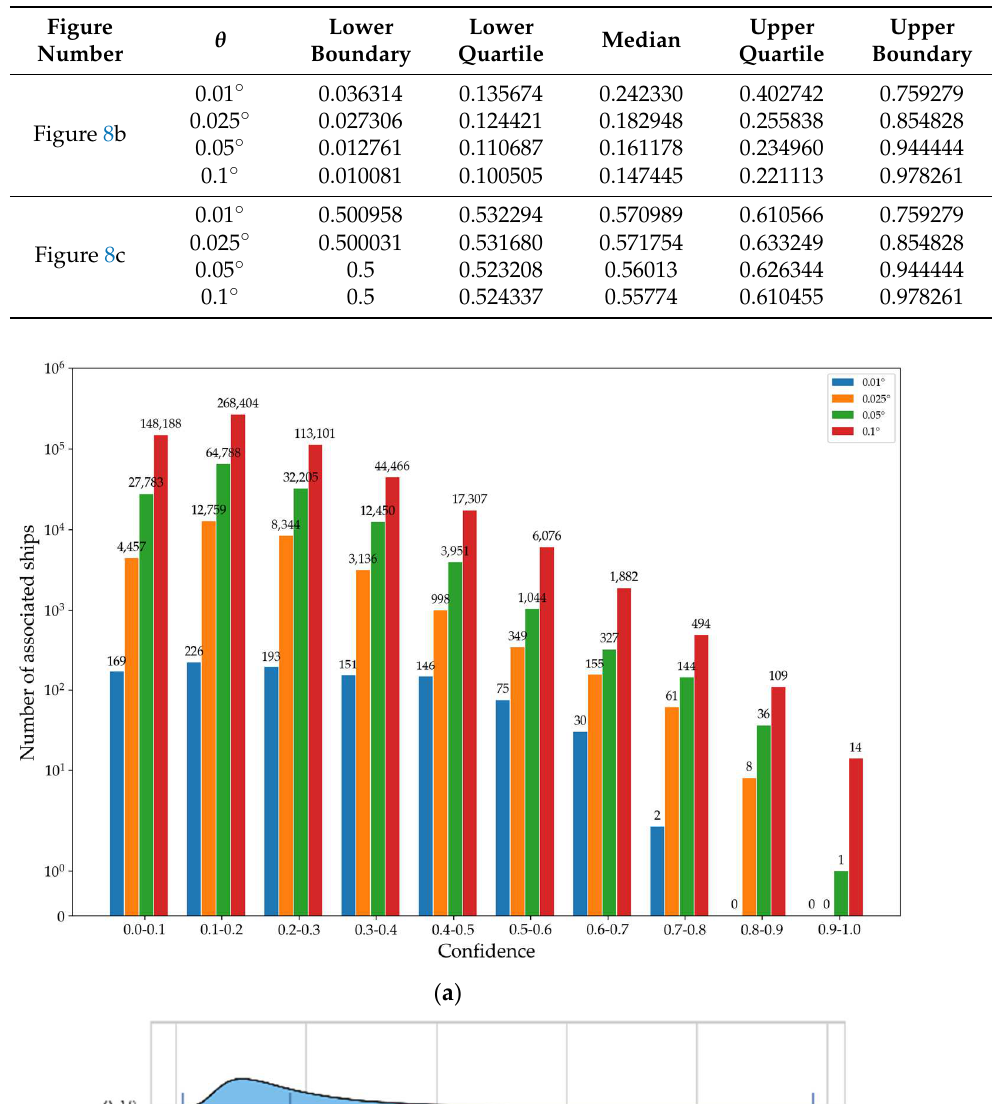
Table 6. Parameters of Figure 8b,c.